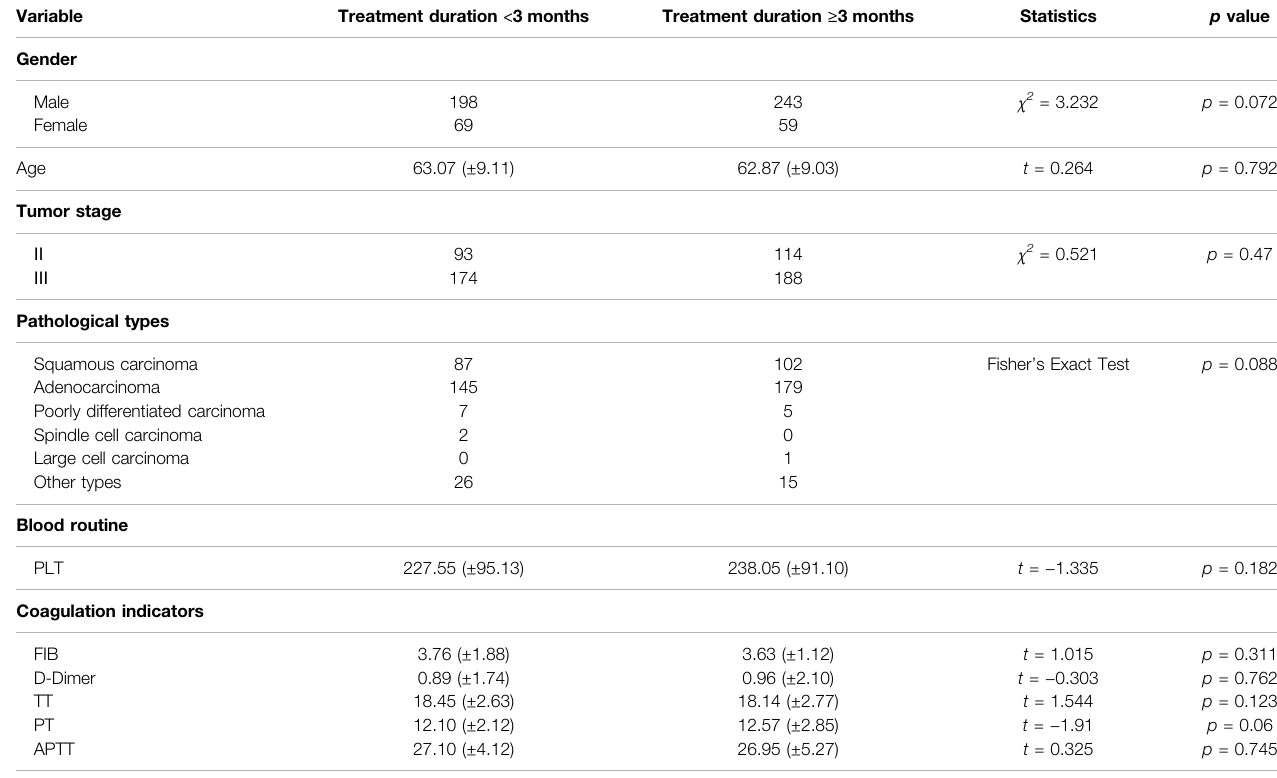
TABLE 2 | Baseline comparison of CPM use for < 3 months and ≥ 3 months group.